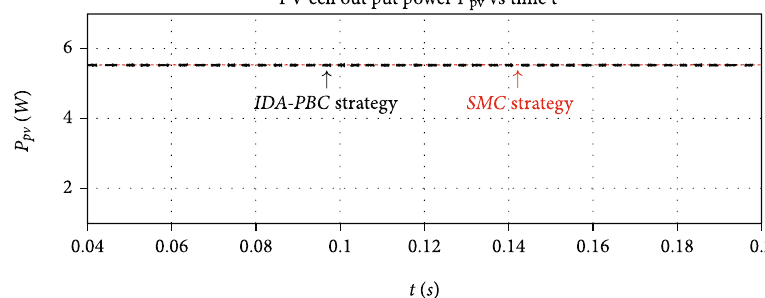
Figure 6: PV cell output power response to given output load levels with IDA-PBC and SMC